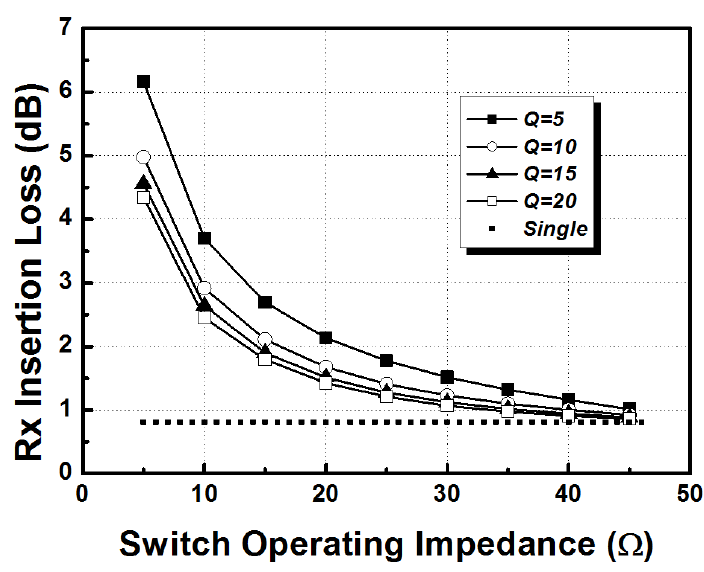
Figure 11. Total loss of the antenna switch with multi (scatter and line) and single-section (scatter) matching network in Rx mode.